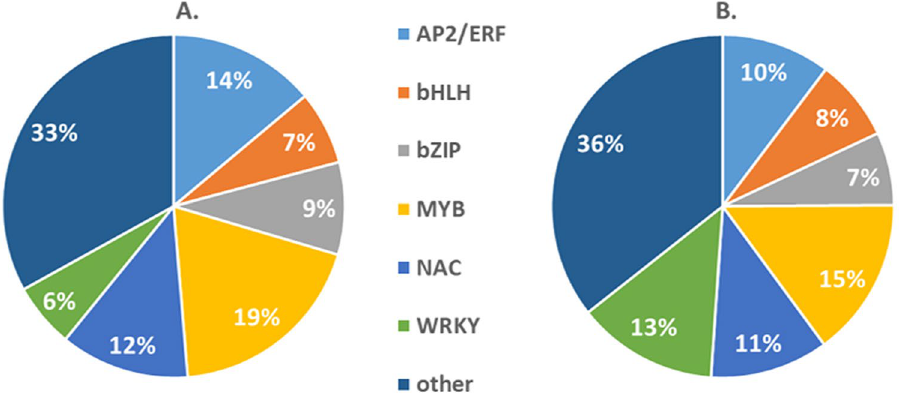
Figure 5. MYB TFs most regulated family over time upon SAA feeding. The most abundant transcription factor classes are shown with their percentages of DEGs after 12 h ( A ) and 24 h ( B ) of SAA feeding. The WRKY TF class undergoes the biggest shift over time, with a more than two-fold increase at 24